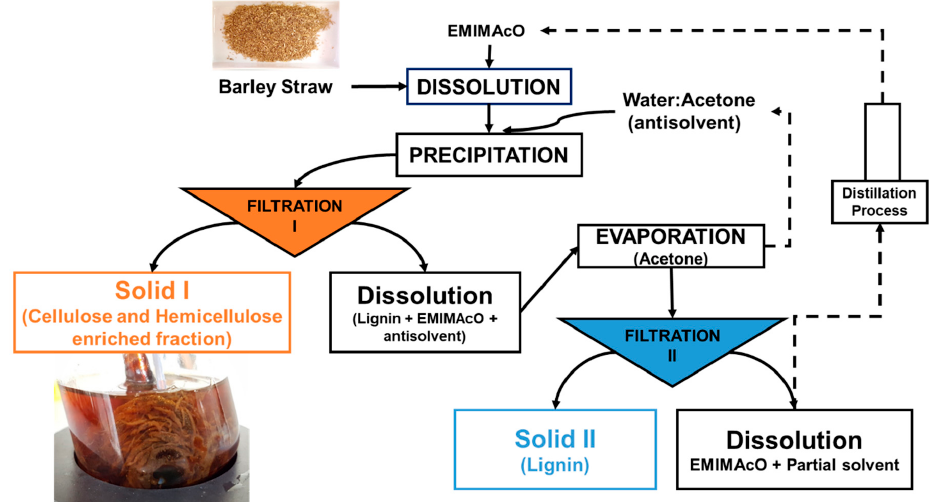
Figure 1. The scheme of the process of dissolution of barley straw in [EMIMAcO] and subsequent precipitation with a water:acetone antisolvent mixture.